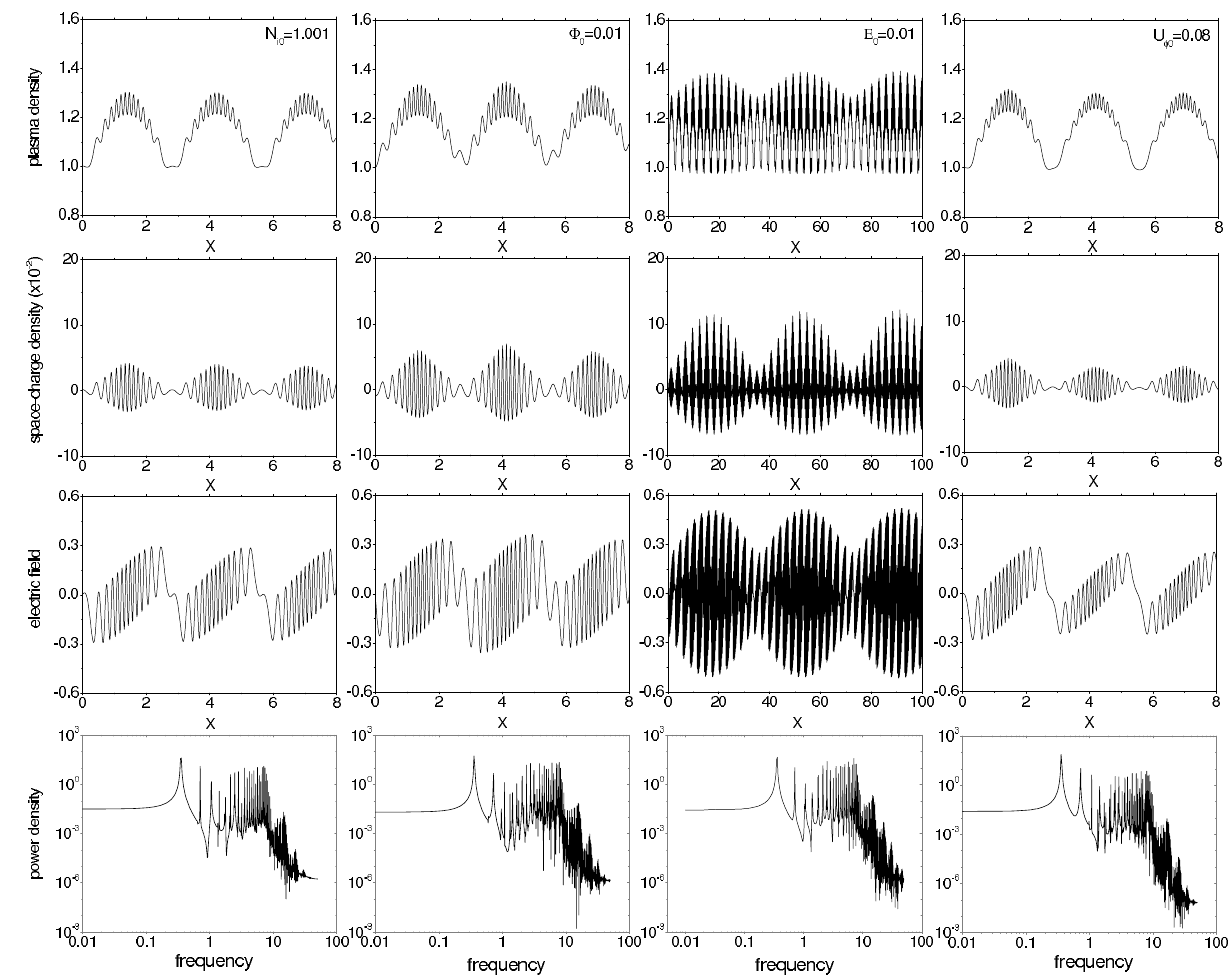
Fig. 9. Same as Fig. 8 but modulated by initial conditions N i0 (left column), 8 0 (middle left column), E 0 (middle right column), and U φ 0 (right column),